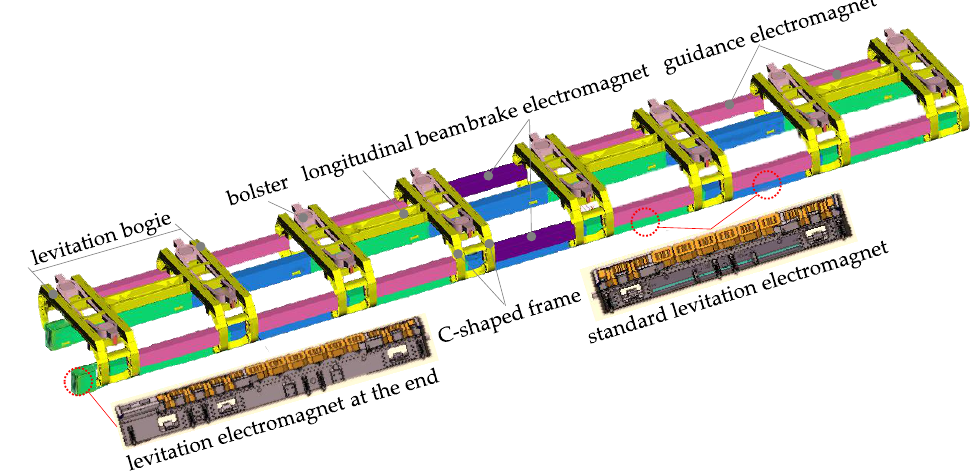
Figure 1. Schematic diagram of the running parts of high-speed maglev